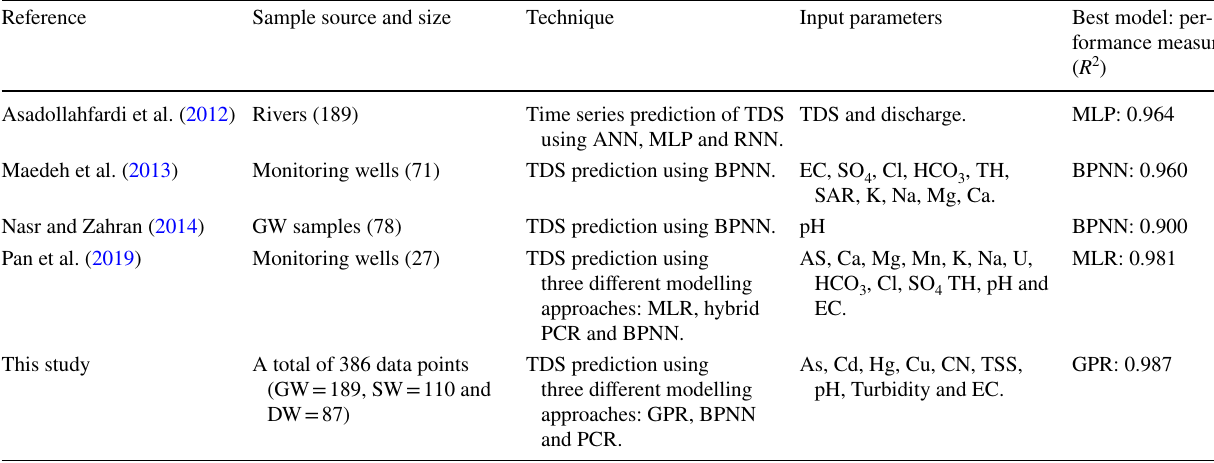
Table 6 Comparison of model prediction accuracy with previous works